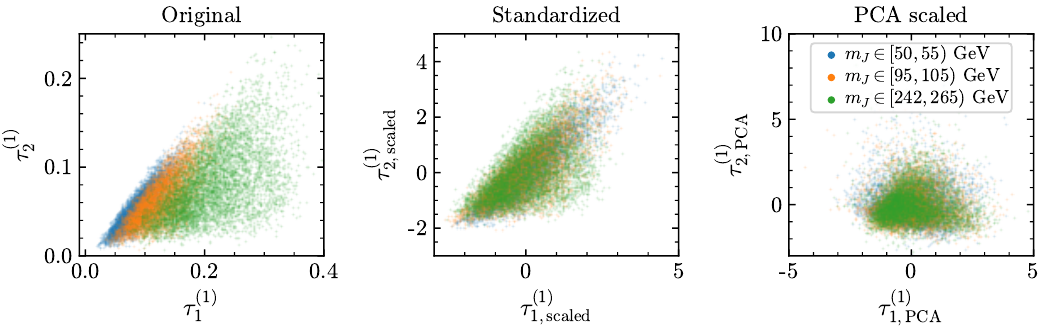
Figure 7: Scatterplot of two benchmark τ variables for QCD events in three differ- ent mass windows. The left panel shows the original variables, before any kind of preprocessing. The events from different mass bins are well separated. The center panel shows the same events after removing the mean and setting the variance of each variable in each bin to unity. The different mass bins now have the same range, but the 2D correlations are still distinct. In the right panel, the events have been standardized and PCA transformed on a linearly independent basis. The different mass ranges are now hard to